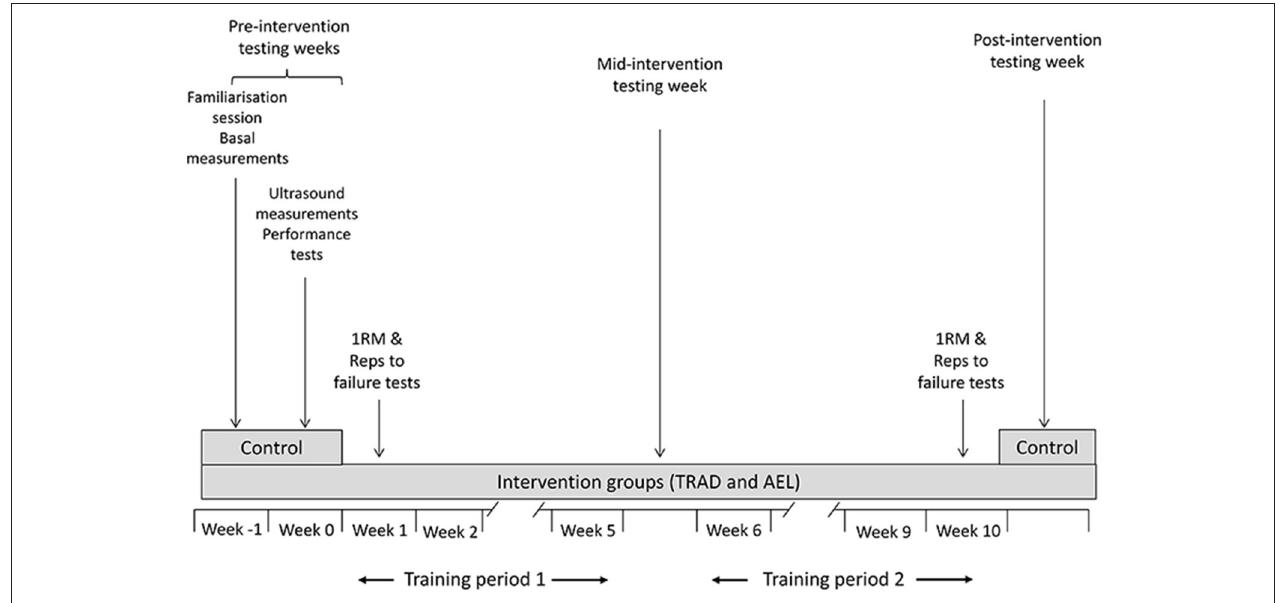
FIGURE 1 | Overall study design including all measurement points.